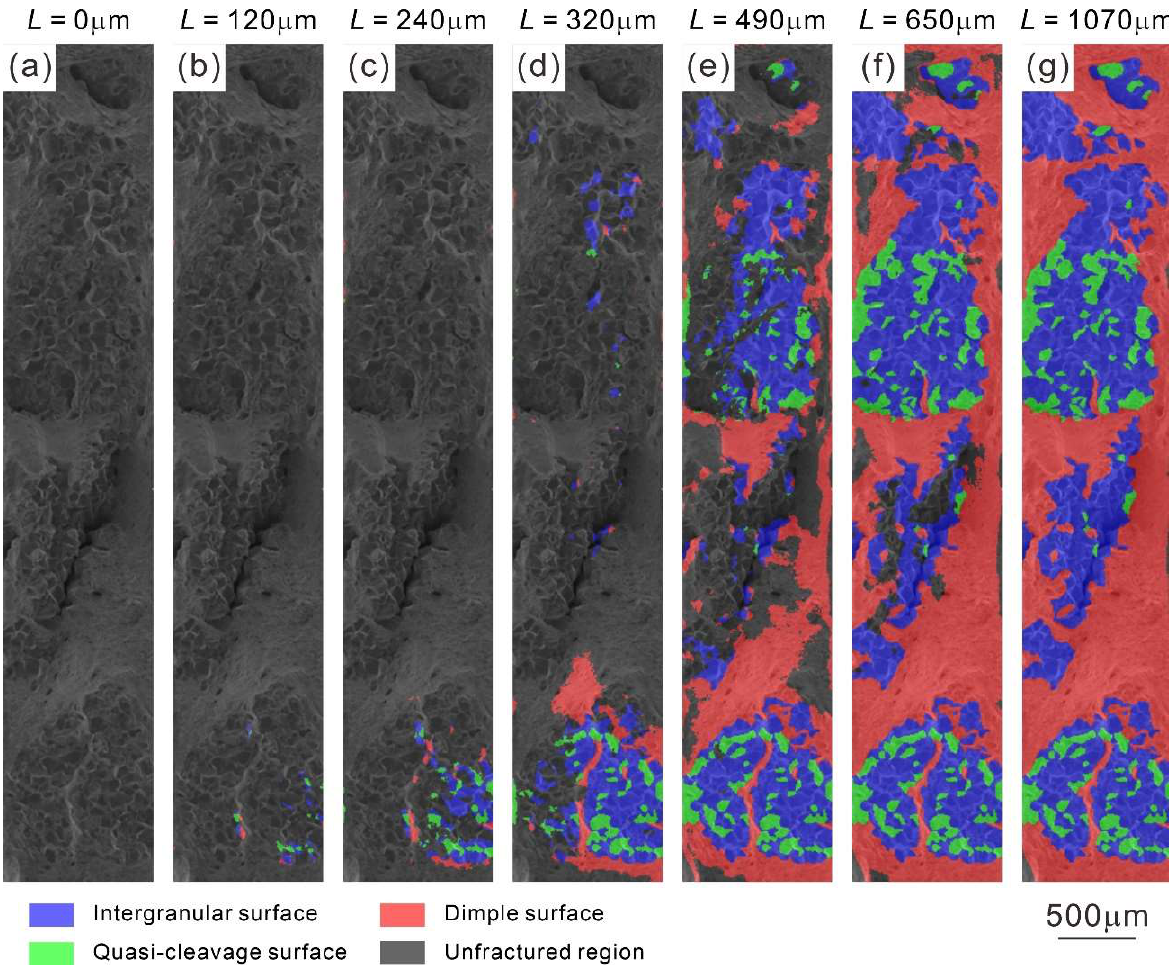
Figure 5. Fracture propagation process reconstructed by FRASTA in the specimen with H D = 0.80 wt. ppm after the constant loading tensile test with an applied stress of 1000 MPa (higher than the 0.2% proof stress). The fractured areas (blue: intergranular fracture, green: quasi-cleavage fracture, and red: ductile fracture) are superimposed on the fracture surface SEM images. L in the figure is the distance between the two fracture surface topographic maps; ( a ) 0 m, ( b ) 120 m, ( c ) 240 m,